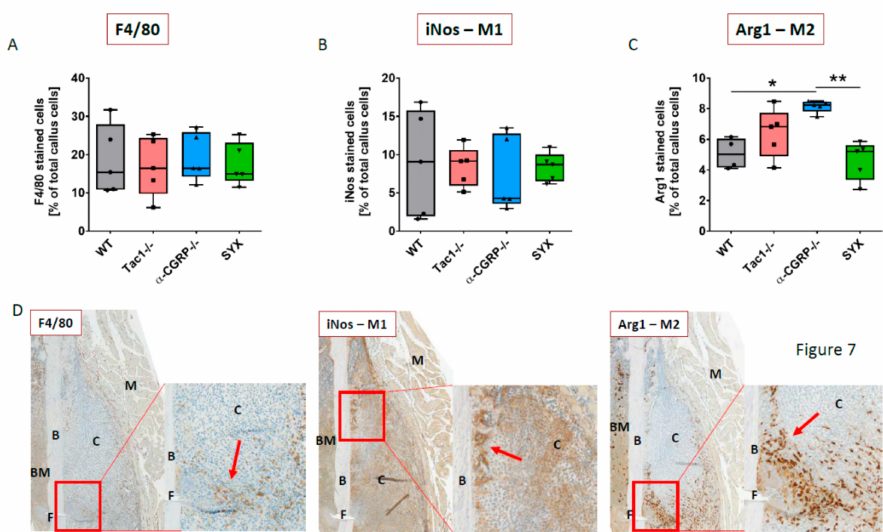
Figure 7. Macrophage subtype profile during the early fracture healing phase. Macrophages in the callus tissue of WT, Tac1 − / − , α -CGRP − / − , and SYX mice 5 days after fracture were detected using F4 / 80 as an overall macrophage marker ( A ), inducible nitric oxide synthase (iNos) as a marker for M1 macrophages ( B ), and Arginase 1 (Arg1) as a marker for M2 macrophages ( C ). Values are calculated as a percentage of total callus cells and are shown as median ± Min / Max. ( D ) Representative images of the F4 / 80, iNos, and Arg1 staining in the callus tissue of a Tac1 − / − mouse. Red boxes demonstrate the enlarged view. Red arrow points to stained cells. Magnification: 20 × (TissueFAXSi plus). B =